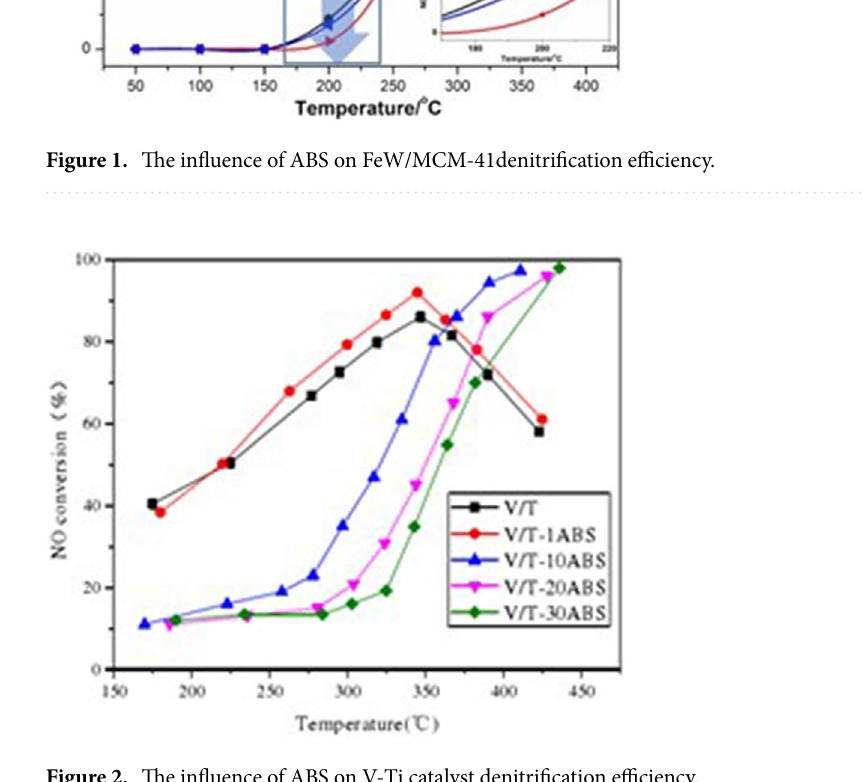
Figure 2. The influence of ABS on V-Ti catalyst denitrification efficiency.